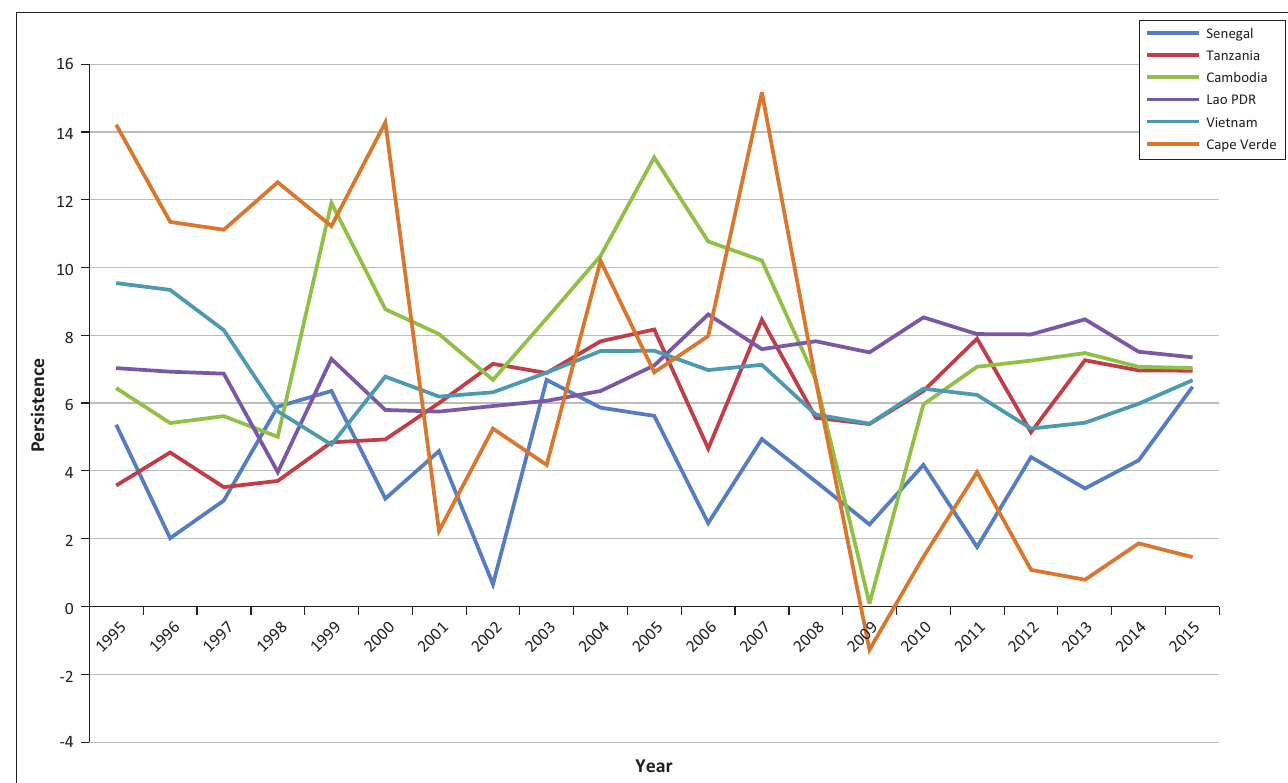
FIGURE 1: Persistence of gross domestic product growth in Senegal and appropriate comparator economies (1995–2015; in